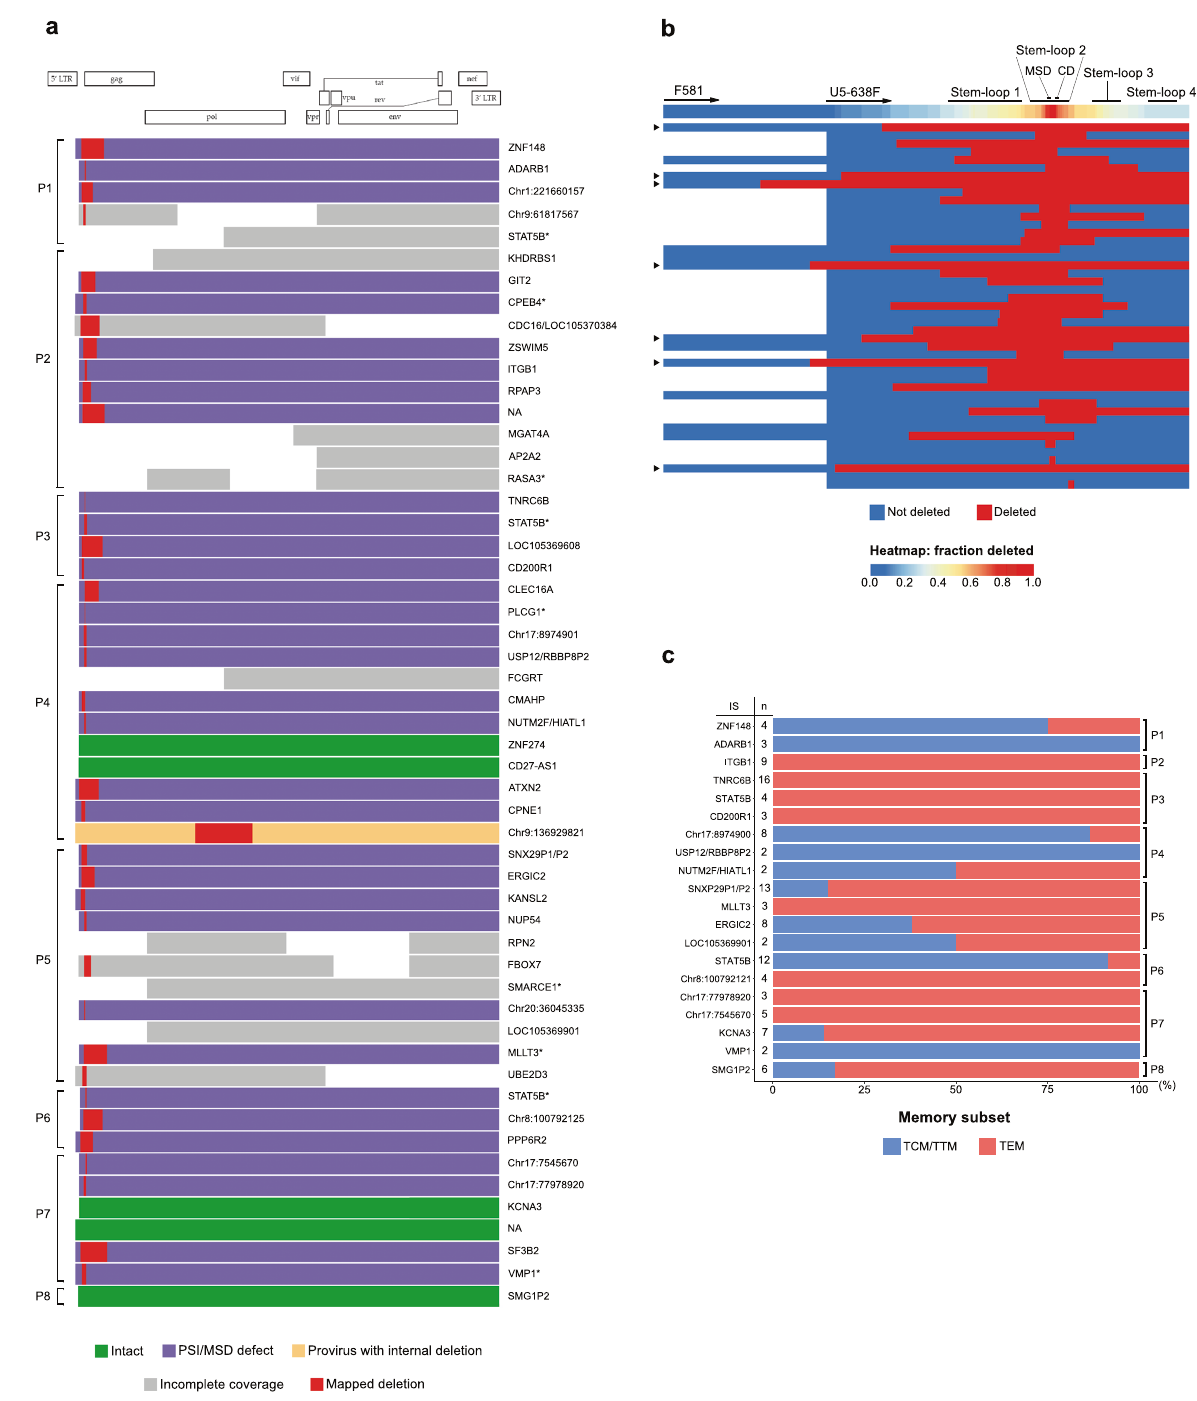
Fig. 2 Near full-length proviral sequencing, integration site analysis, and subset analysis on p24-producing cells from ART-treated individuals. a Virogram showing the near full-length proviral genomes recovered from eight ART-treated individuals. Proviral genomes were reconstructed using a 5- amplicon, 2-amplicon, or 4-amplicon PCR approach. Corresponding integration sites (IS) are indicated at the right-hand side of each proviral genome. Cancer-related genes are indicated with an asterisk. b Heatmap of the deletions in the 5 ′ UTR region, including the Ψ packaging signal. The second-round forward primers for the 2-amplicon (F591) and 5-amplicon (U5-638F) NFL PCR approach are annotated with arrows on the heatmap. Proviruses with a deletion spanning the U5-638F primer are indicated with a triangle at the left-hand side of each provirus. MSD major splice donor, CD cryptic donor. c Memory subset distribution of clonal p24-producing cells. The number of cells within each clone is indicated at the left-hand side of each horizontal bar. TCM central memory T cell, TTM transitional memory T cell, TEM effector memory T